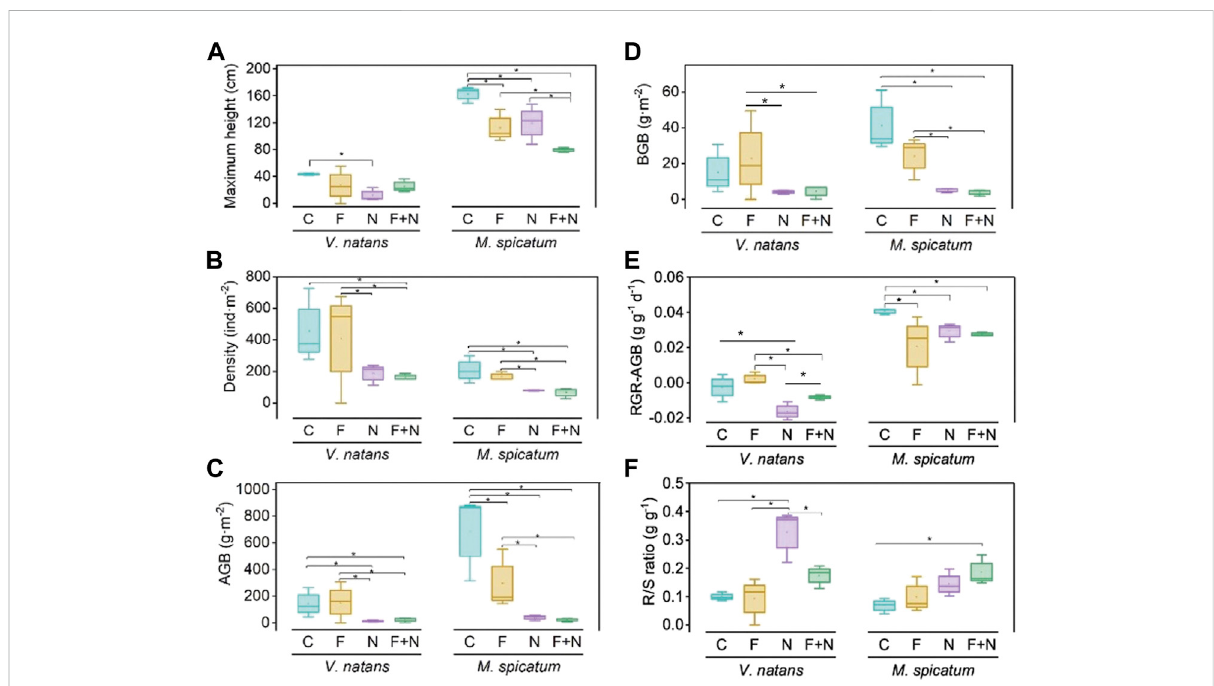
FIGURE 3 Themaximumheight (A) ,density (B) ,above-groundbiomass(AGB) (C) ,below-groundbiomass(BGB) (D) ,relativegrowthrateofabove-ground biomass (RGR-AGB) (E) and root biomass to shoot biomass ratio (R/S ratio) (F) of Vallisneria natans and Myriophyllum spicatum in each treatment at the end of experiment. See Figure 1 for the meaning of various treatments. “ * ” indicates signi fi cant differences at the 0.05 signi fi cance level determined by least signi fi cance difference test